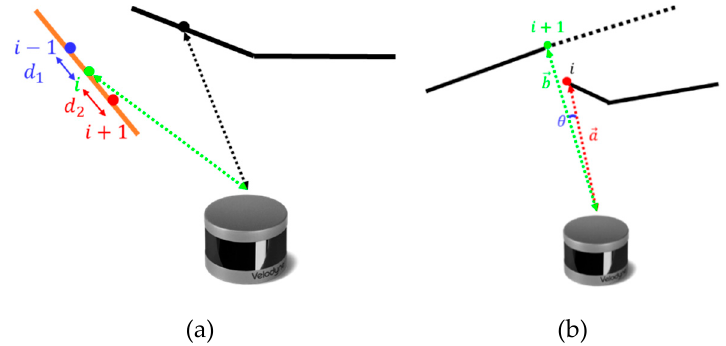
Figure 2. Unreliable extraction from two situations: ( a ) roughly parallel situation, ( b ) occluded situation.